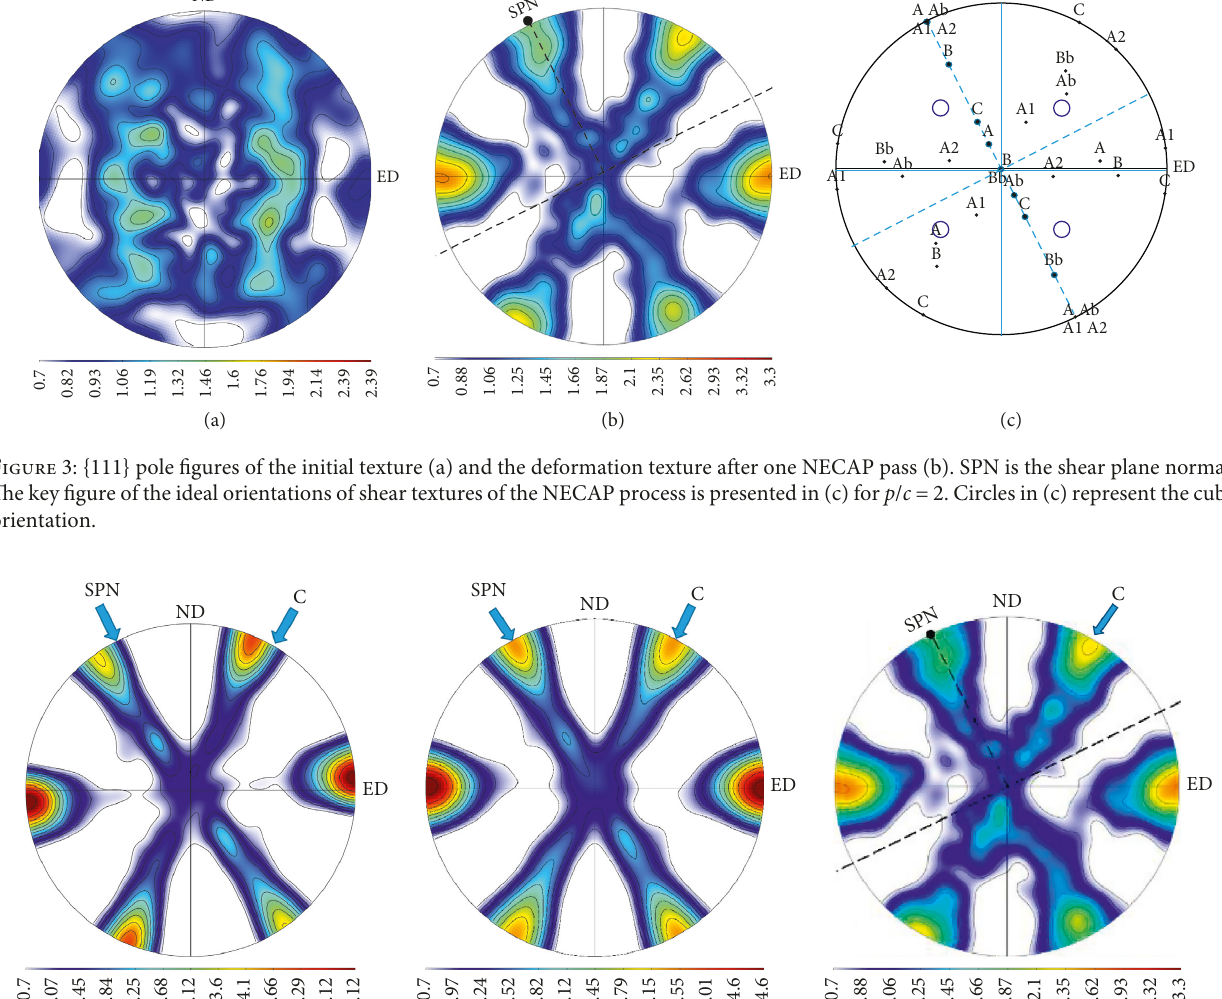
Figure 4: Simulated textures in {111} pole figure using the old flow line function (a) and the newly proposed one (b), in comparison with the experiment (c). SPN indicates the ideal shear plane normal, and C is the exact position of one of the {111} reflections of the C texture component.